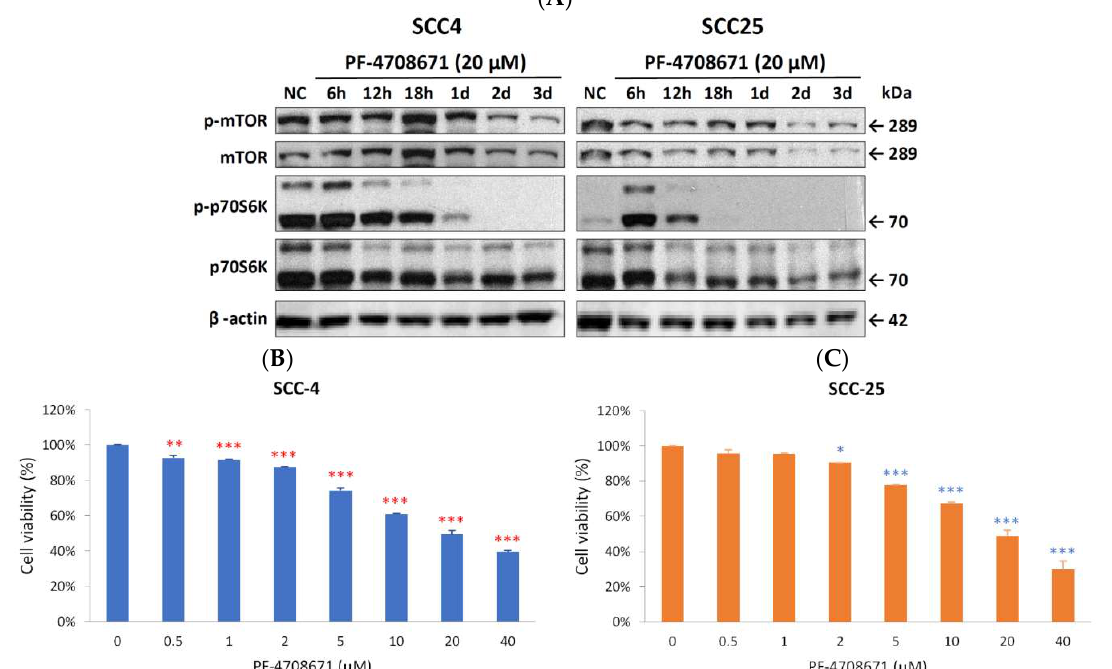
Figure 4. Phospho-p70S6K inhibitor (PF-4708671) suppressed phospho-p70S6K expression and cell proliferation in SCC-4 and SCC-25 cells. ( A ) As determined using Western blotting,